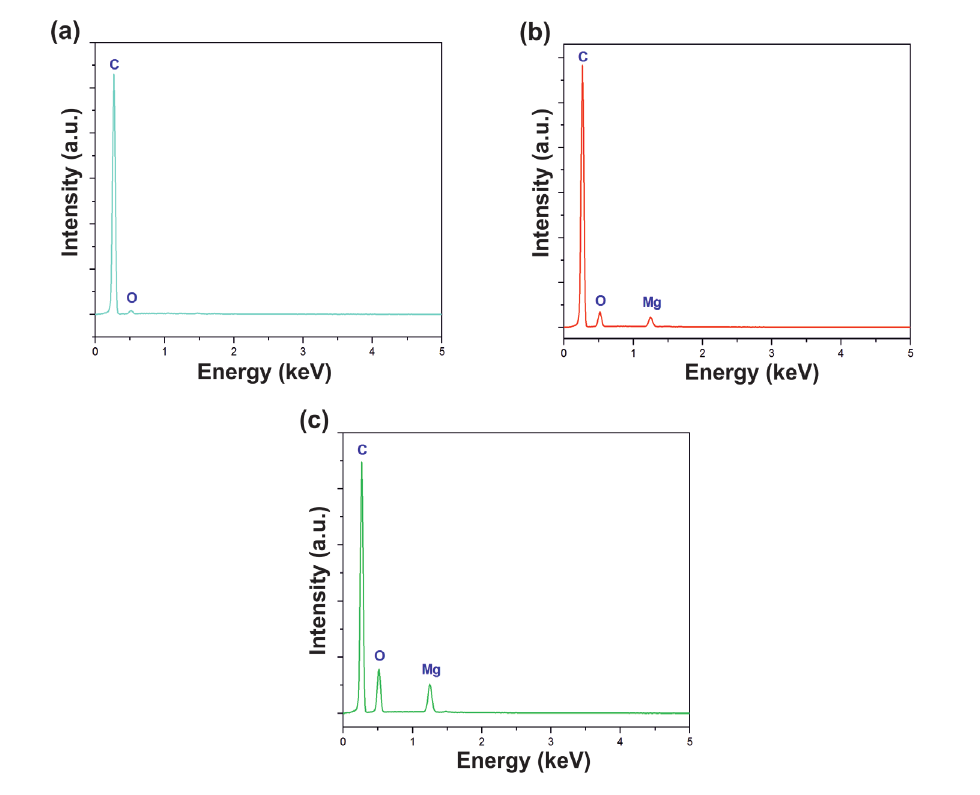
, (c) PP/PP-g-MAH/30%Mg(OH) 2